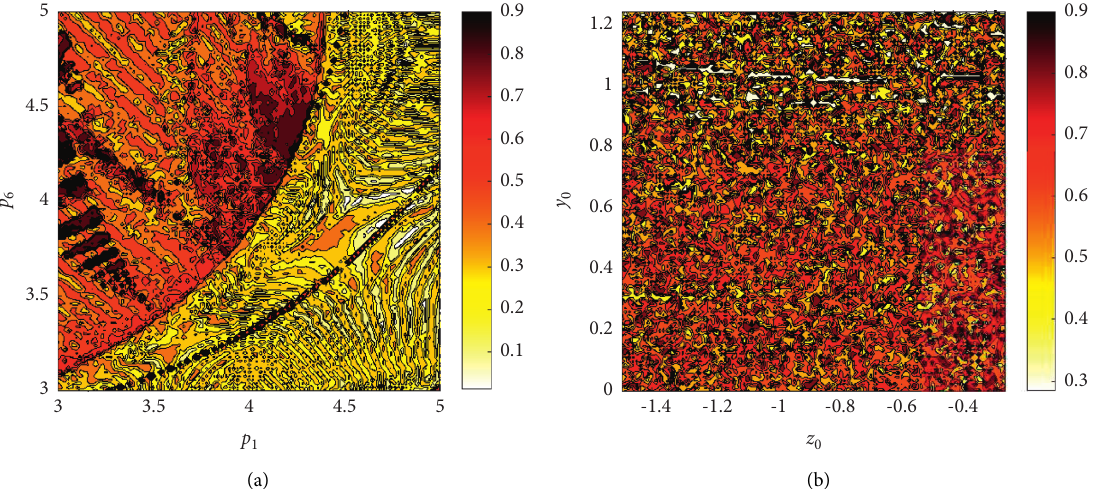
Figure 7: Spectral entropy distribution of the system in the (a) p